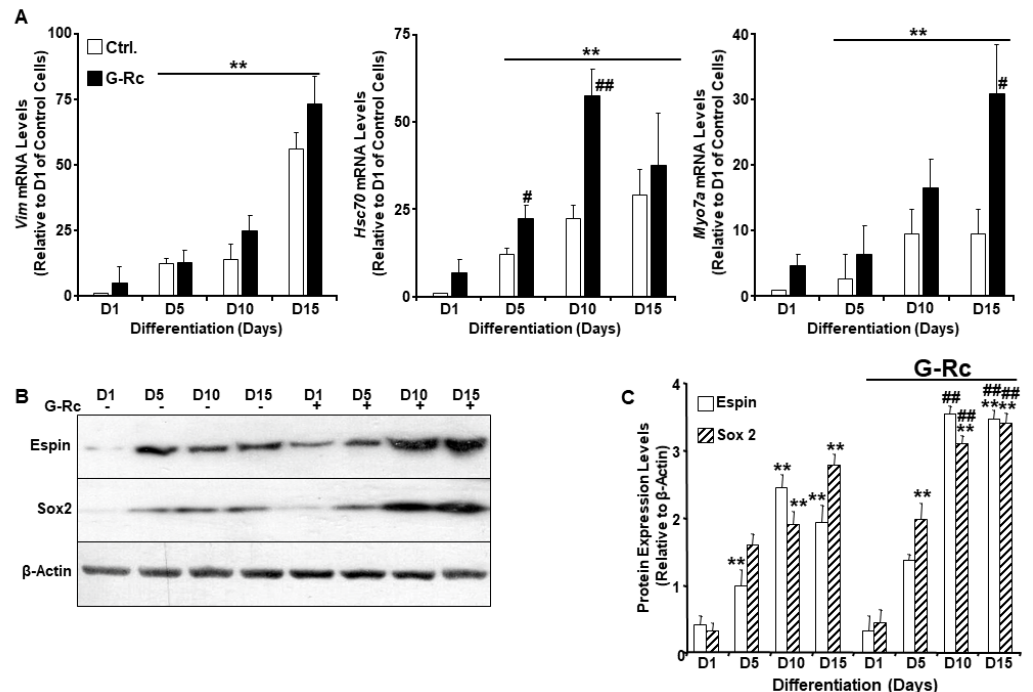
Figure 3. A human physiologically relevant dose of G-Rc promotes the differentiation of UB/OC-2 into functional sensory hair cells. ( A ) Quantitative (q)RT-PCR of Vim , Hsc70 , and Myo7a mRNA levels in control and G-Rc (25 µ g/L) treated cells on days 1, 5, 10, and 15 of differentiation. Data are normalized to Tbp and expressed as fold change relative to undifferentiated (D1) control cells non-treated with G-Rc. Results are representative of three independent experiments and data are expressed as mean + SEM. ** p < 0.01 denotes a significant difference between indicated time points and D1 for each treatment. # p < 0.05 and ## p < 0.01 indicate significant difference between G-Rc- treated and control cells non-treated with G-Rc. ( B , C ) Representative immunoblots ( B ) and bar graph quantitative assessment ( C ) of Espin and Sox2 in total cell lysates from differentiating UB/OC-2 with and without G-Rc treatment(25 µ g/L). Results are representative of three independent experiments, and data are expressed as mean + SEM. ** p < 0.01 indicates a significant difference between indicated time points and D1 for each treatment. ## p < 0.01 indicates significant difference between G-Rc-treated and control cells non-treated with